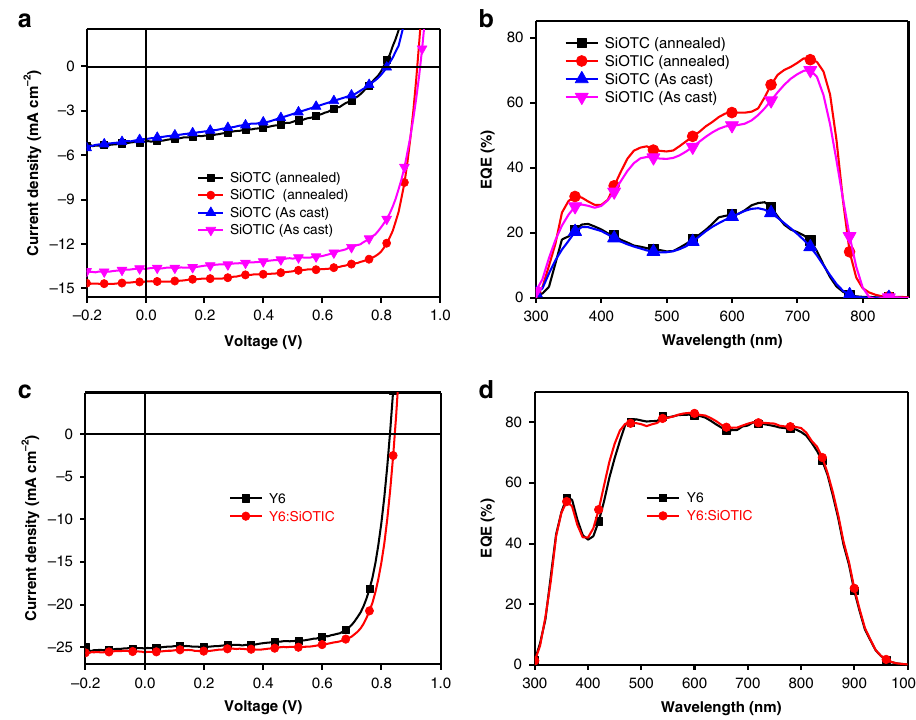
Fig. 5 Device performance of the corresponding solar cells. a J – V curves of the PM6 : SiOTIC -based binary device under 100 mW cm − 2 AM 1.5 G irradiation. b The corresponding EQE curves of the PM6 : SiOTIC -based binary device. c J-V curves of the PM6 : Y6 and PM6 : Y6/SiOTIC -based binary and